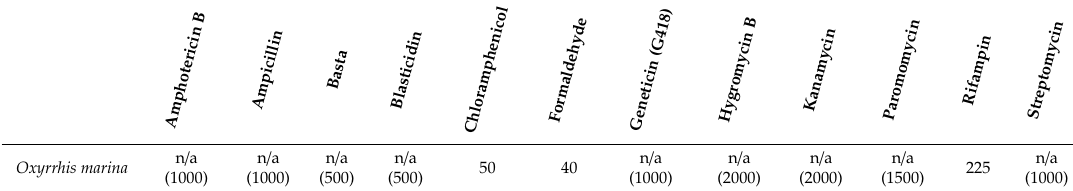
Table 1. Di ff erent selection markers used on O. marina . The reported values are in µ g / mL and are the amount of selective agent required to kill the entire population in 7–10 days. The antibiotics found to not work are noted by “n / a” and followed by the highest concentrations tested in